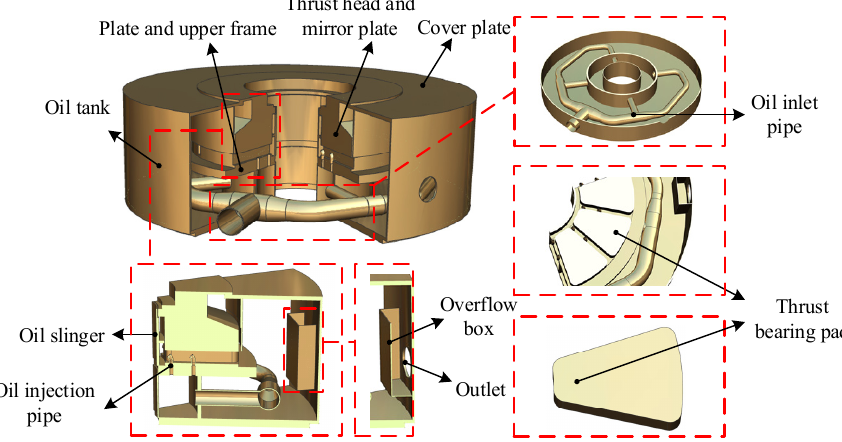
Figure 14. Thrust bearing model of external circulation of the external pump.